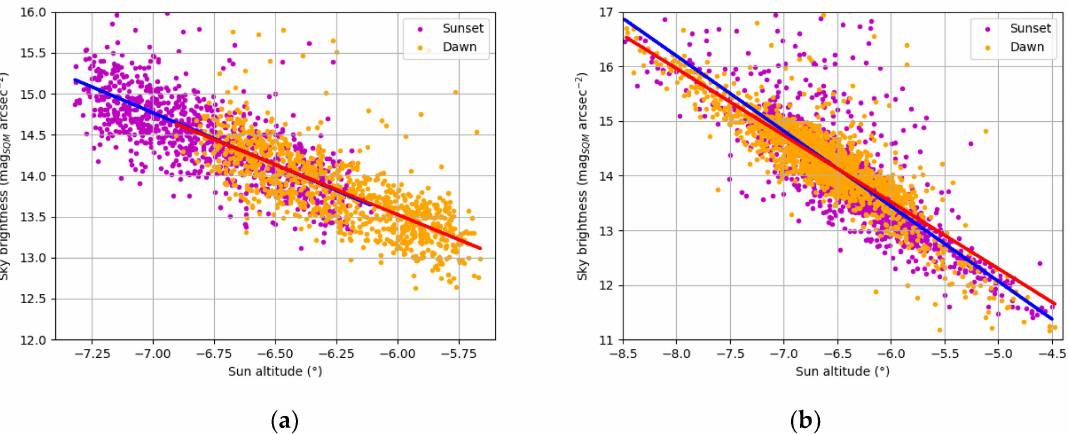
Figure 6. Sky brightness versus Sun’s altitude corrected by the angular error caused by the time shift at Pennar ( a ) and at Ekar ( b